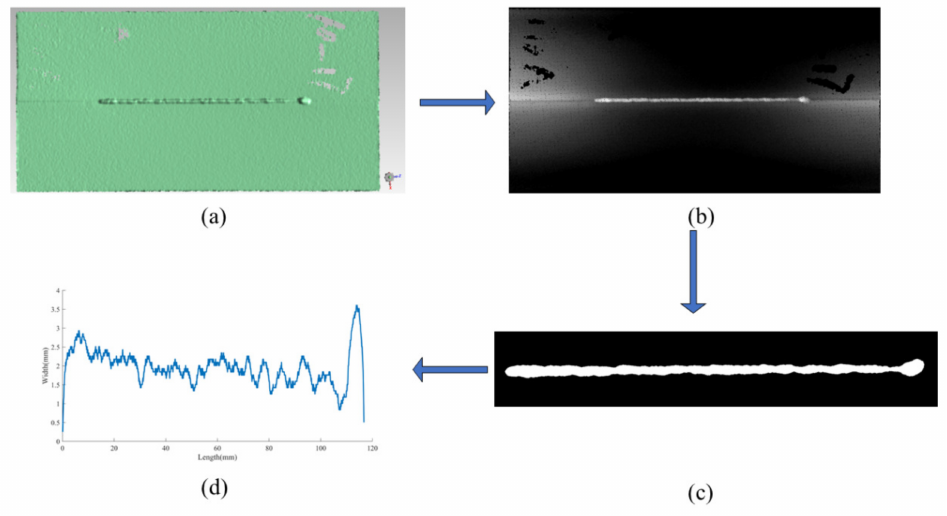
Figure 3. Flow chart for extraction of the bottom width of weld. ( a ) Bottom weld point cloud ( b ) Grayscale image of height ( c ) Binarised image of weld geometry ( d ) The length–width relationship curve of the bottom